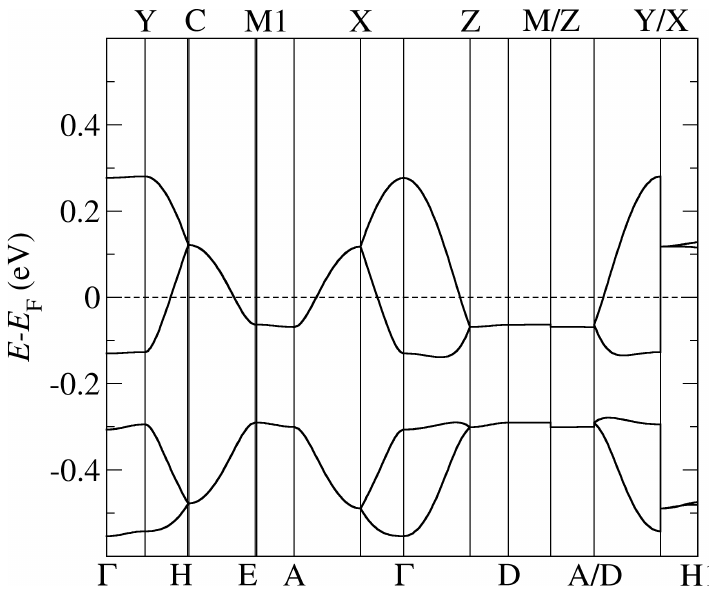
Figure 3. The band structure of κ -AgCN obtained by using PBE-vdW and the pseudopotentials C, Ag. Γ = (0,0,0); X = (0,0,1/2); Y = (1/2,0,0), Z = (0,1/2,0) in the units of reciprocal lattice